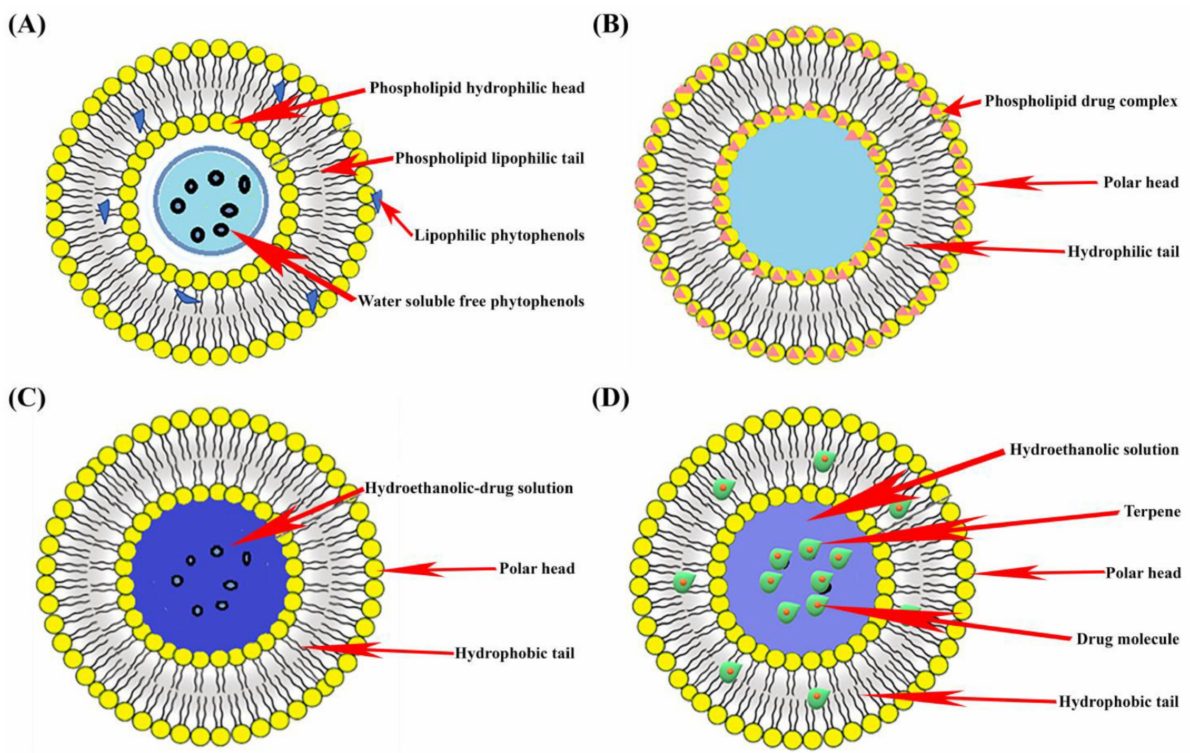
Figure 1. Graphical representation of different types of nanodelivery systems: ( A ) Liposome; ( B ) Phytosome; ( C ) Ethosome; and ( D )